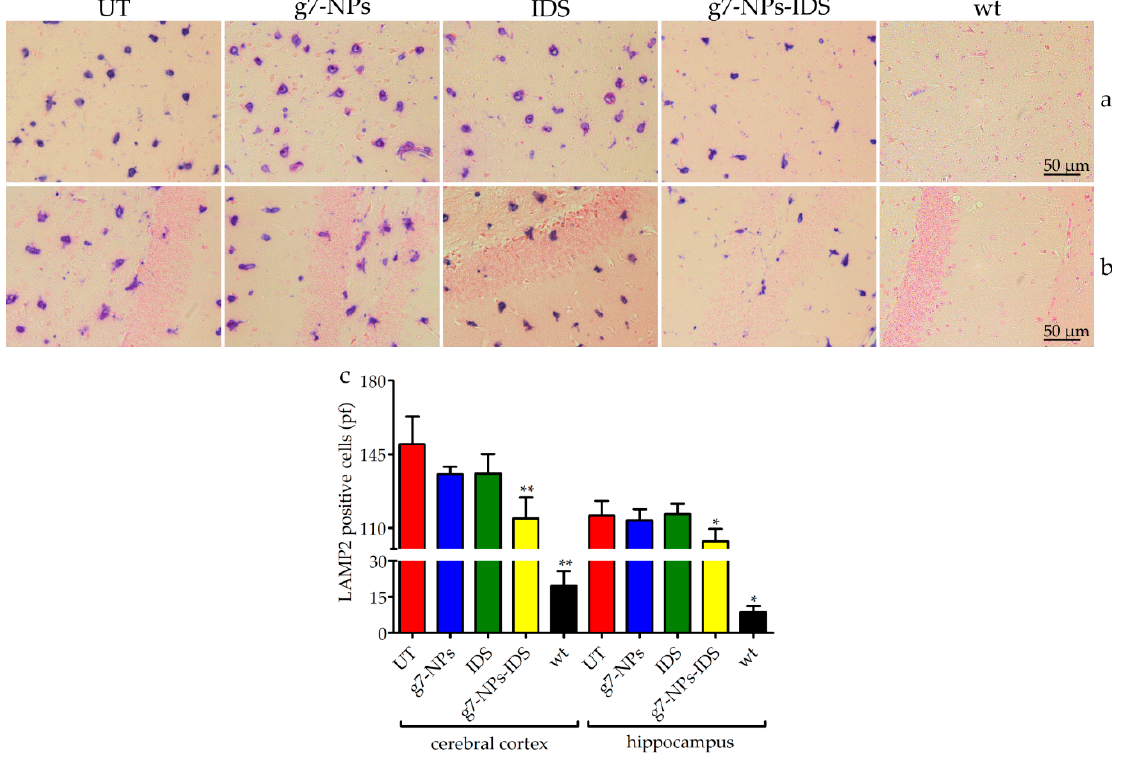
Figure 4. Immunohistochemical analysis of LAMP2 in the brain. Immunohistochemical analysis of LAMP2 in Ids-ko mice treated with 0.9% NaCl (untreated, UT), g7-NPs, free IDS, g7-NPs-IDS, and in wt mice, after 6 weeks of treatment. Representative images of ( a ) cerebral cortex and ( b ) hippocampus of 7 µ m sections stained with LAMP2 antibody (purple spots) and counterstained with 0.5% Eosin Y solution. ( c ) Quantification of positive cells to LAMP2 in the cerebral cortex and hippocampus. n = 5 mice / group, pf = per field. All data are mean ± SD. Asterisks indicate a statistically significant di ff erence from UT mice (Mann–Whitney U test, * p < 0.05, ** p < 0.01). All Ids-ko mice groups presented a statistically significant di ff erence from wt